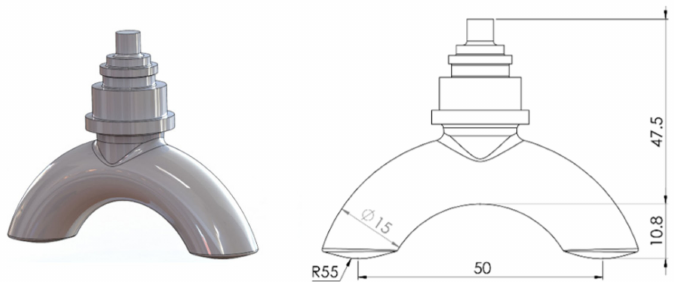
Figure 10. The final design and schematic representation (dimensions in milimiters) of the dual-tip applicator, using the proposed solution.